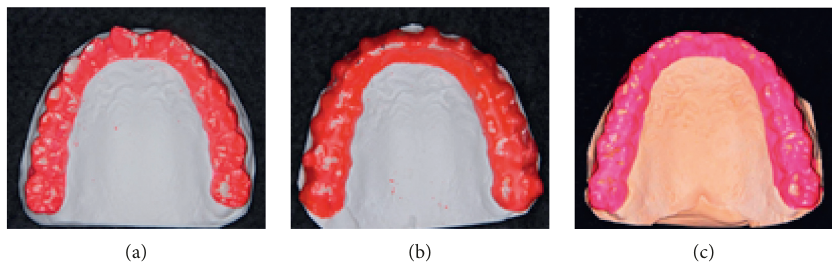
Figure 4: Brux Checker findings. (a) Before orthodontic treatment, (b) just before removal of the orthodontic appliance, and (c) at 2 years after retention.